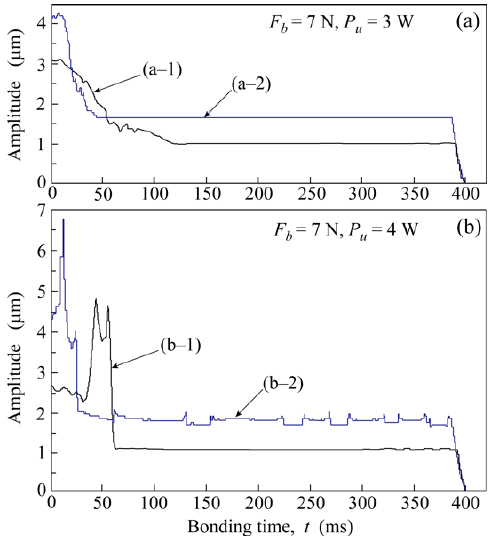
Figure 3. Change in ultrasonic vibration amplitude of tool head during ultrasonic bonding: ( a ) Under the bonding condition of F b = 7 N and P u = 3 W. (a–1) Result measured simultaneously with the video taken at F rate = 10 4 fps. (a–2) Result measured simultaneously with the video taken at F rate = 10 3 fps; ( b ) Under the bonding condition of F b = 7 N and P u = 4 W. (b–1) Result measured simultaneously with the video taken at F rate = 10 4 fps. (b–2) Result measured simultaneously with the video taken at F rate = 10 3 fps.